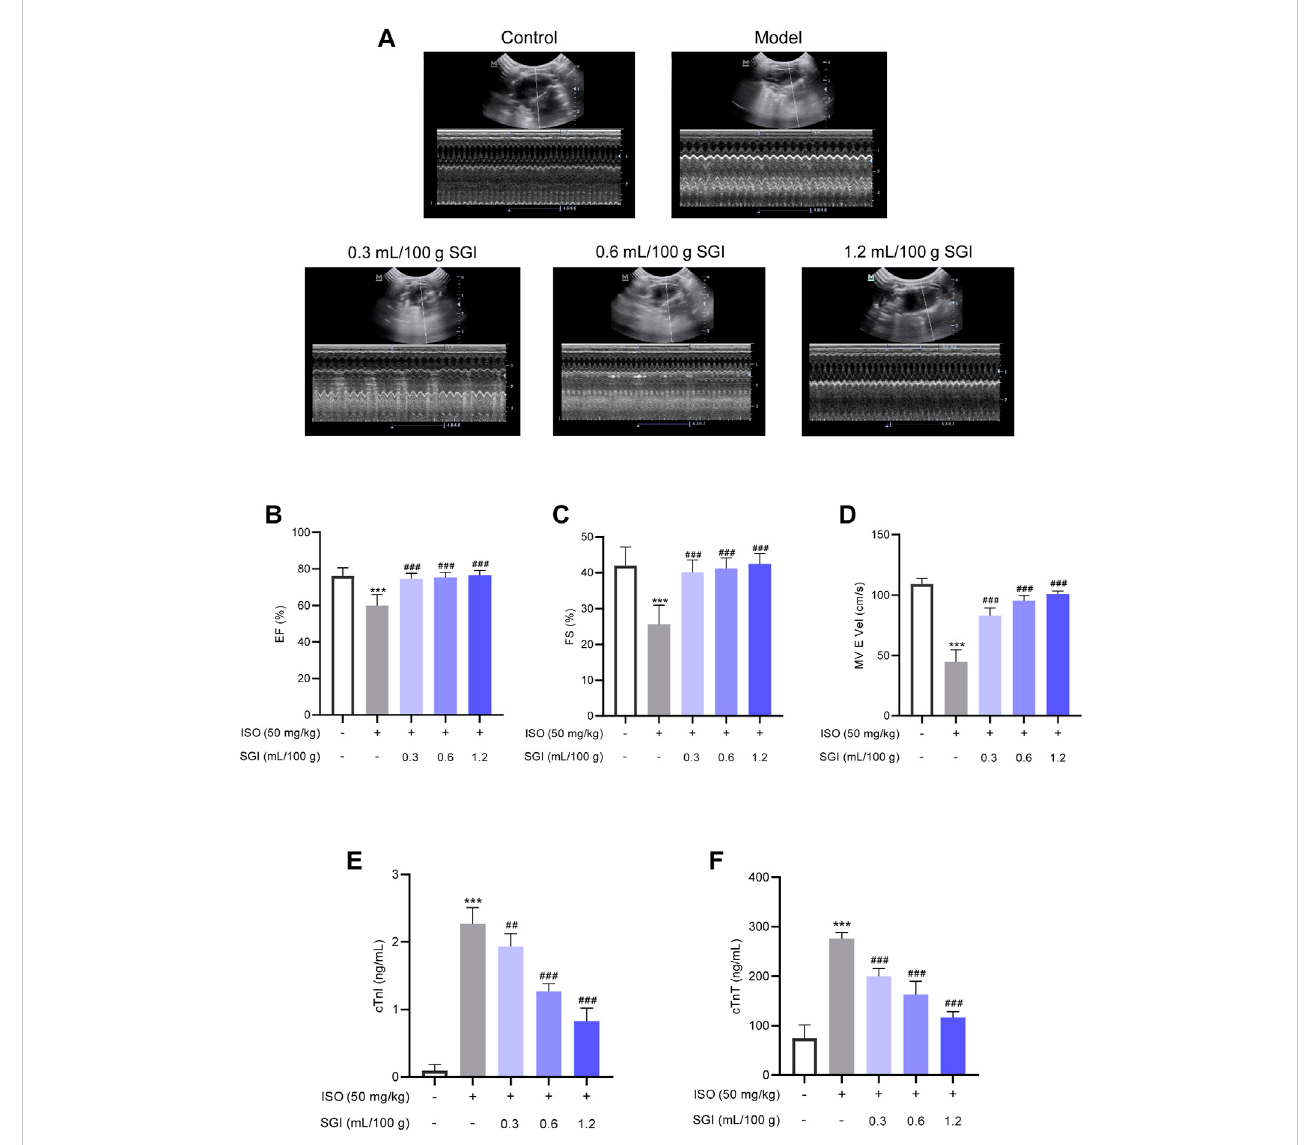
FIGURE 3 SGI improves ISO-induced changes in cardiac function. (A) Representative M-mode echocardiography images. (B) Left ventricular ejection fraction [EF(%)]and (C) leftventricularfractionalshortening[FS(%)]re fl ectLVsystolicfunction. (D) MV Evelre fl ectsLVdiastolicfunction.TheeffectofSGIontheserum cardiac markers (cTnT (E) and cTnI (F) ) in ISO-induced MI in rats. *** p < .001 vs. the control group; ### p < .001 vs. the model